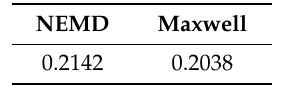
Table 1. Thermal conductivity (W/(m · K)) of system (d) at 320 K.